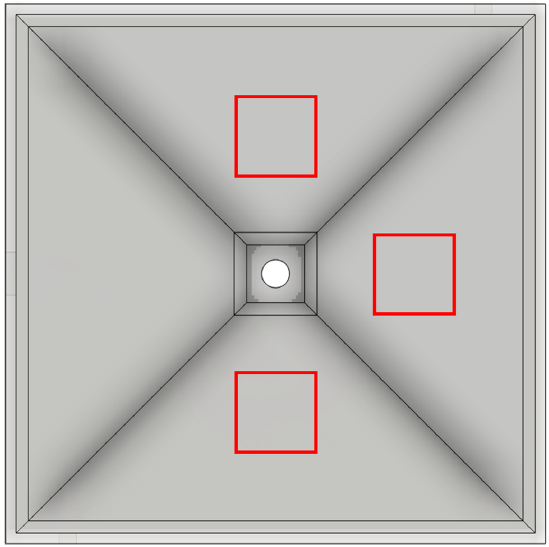
Figure 5. Detection chamber (top view) and the positions of the three square fields (highlighted in red) for the measurement of the mean gray value.